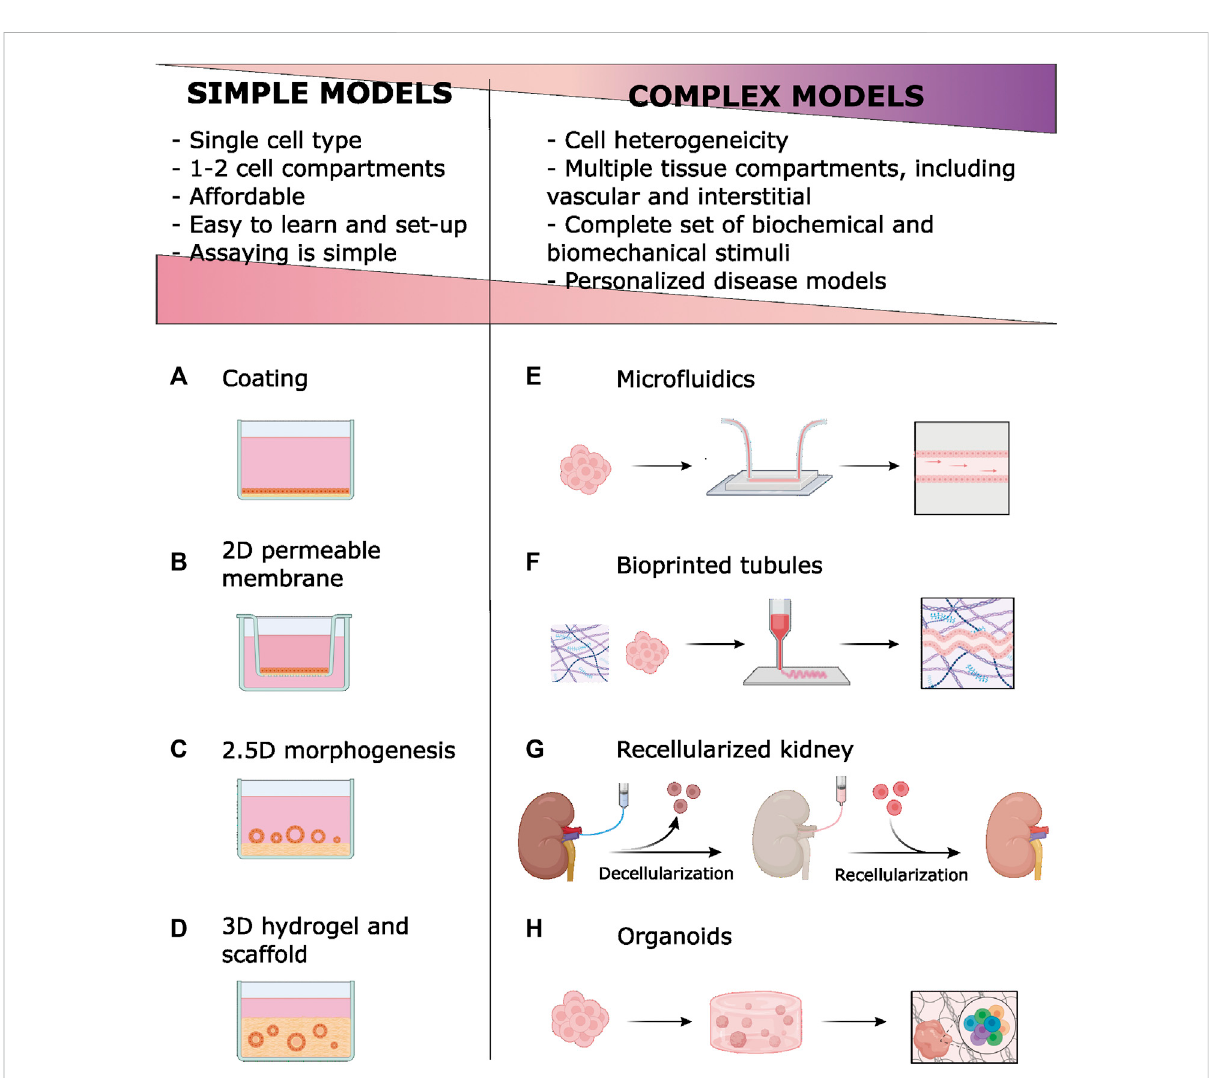
FIGURE 1 Simple models in vitro of renal epithelia employ ECM components of basal membrane (BM) and extracellular matrix (ECM) Coatings are simply ECMmaterials,usuallycollagen,adsorbedtotheplastic (A) orpermeablemembrane (B) .Permeablemembranesandscaffold-basedmodelsimprove epithelial polarity by offering two fl uid compartments. Tubulogenesis is stimulated by growing renal epithelial cells onto (C) or within (D) hydrogels. New technologies [micro fl uidics (E) , bioprinting (F) , ECM decellularization (G) and organoids development (H) ] enable complex models that introduce cell heterogeneity, vascular and interstitial compartments, and biomechanical stimuli. Compared to simpler, conventional models, these modelshavedisadvantagesrelatedtotheircomplexity.However,complexmodelsallowformorefaithfulmodelingofkidneyfunctionanddisease.A licensed version of BioRender was used to prepare this fi